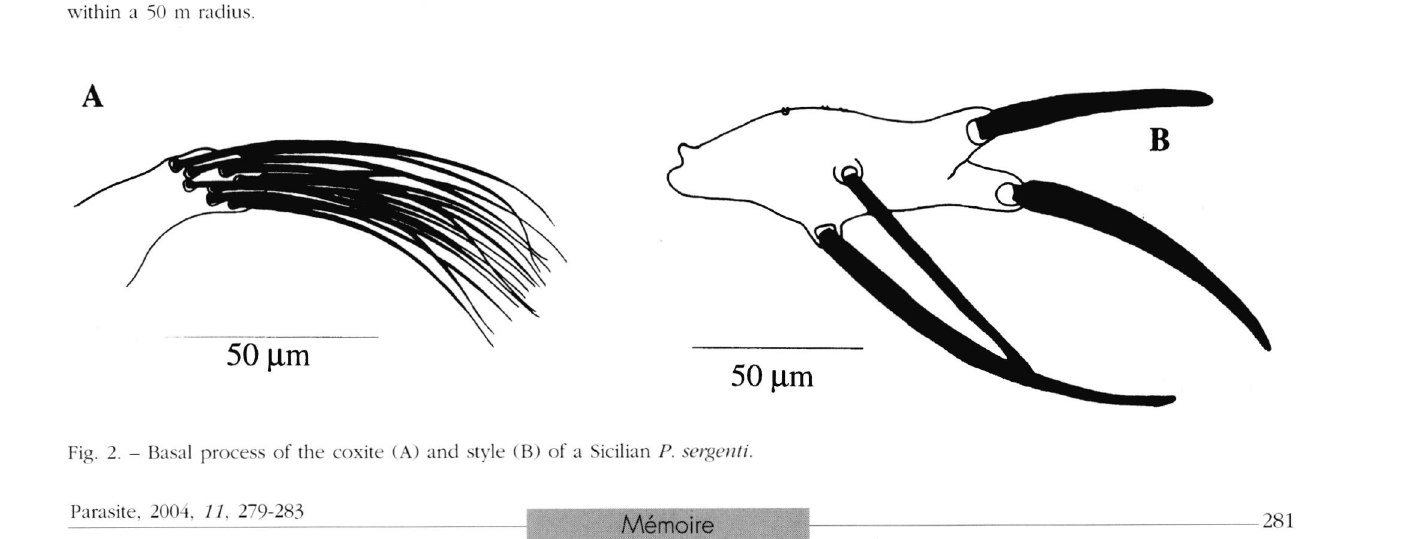
281 Parasite, 2004. 11,